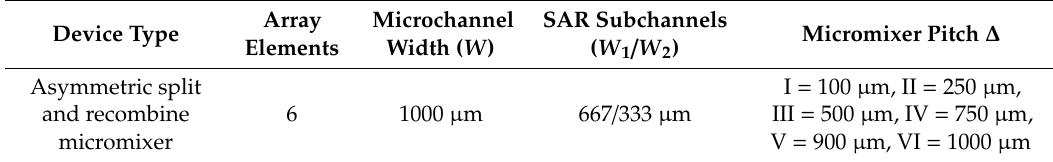
Table 1. Micromixers array employed to assess the manufacturing technology.